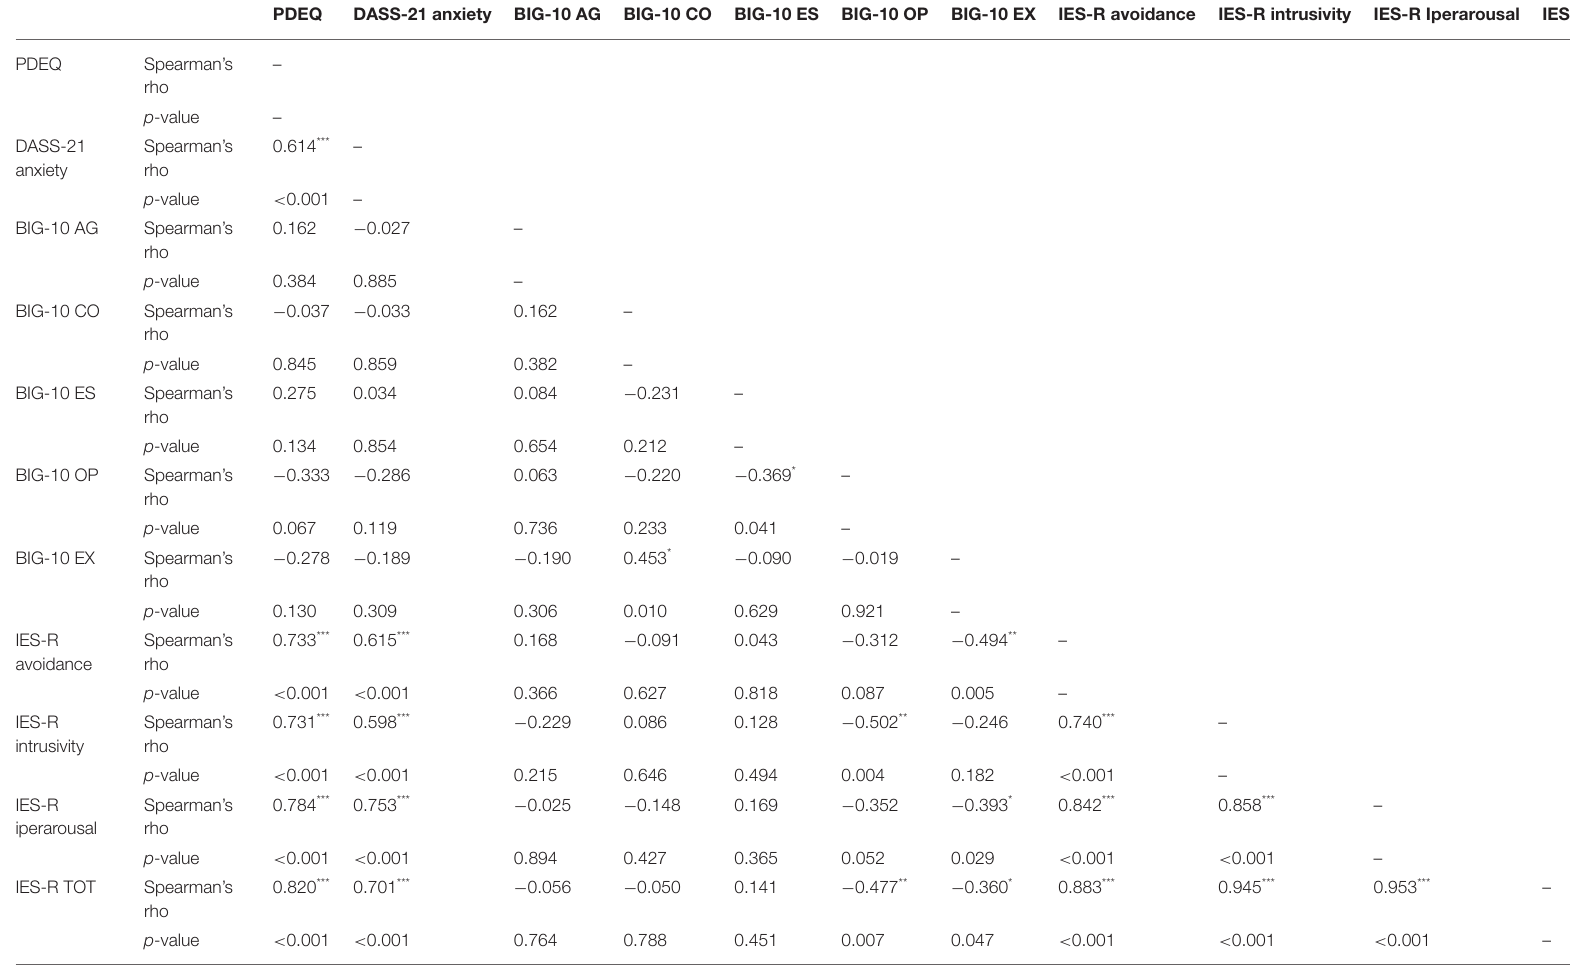
TABLE 4 | Spearman correlations among emotional and psychological measurement in September 2020